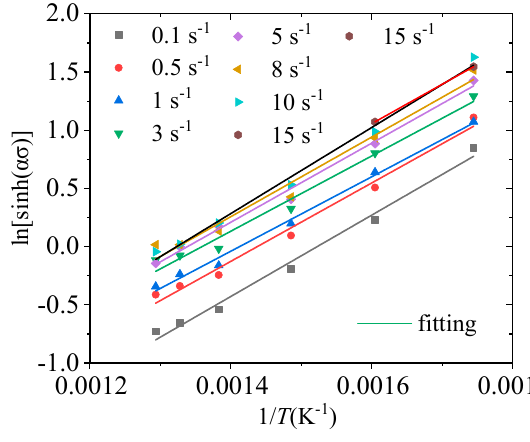
Figure 8. The relation curve of 𝑙𝑛 𝑠𝑖𝑛ℎ(cid:4666)𝛼𝜎(cid:4667) (cid:3398) 𝑙𝑛𝜀(cid:4662) .